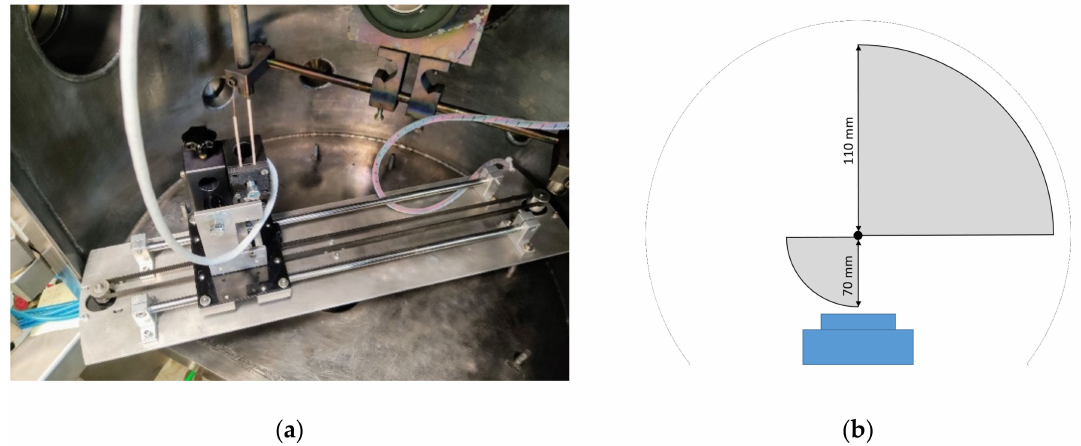
Figure 4. ( a ) General view of 2D moving platform with mounted emissive probes and ( b ) the definitions of measurement domain.